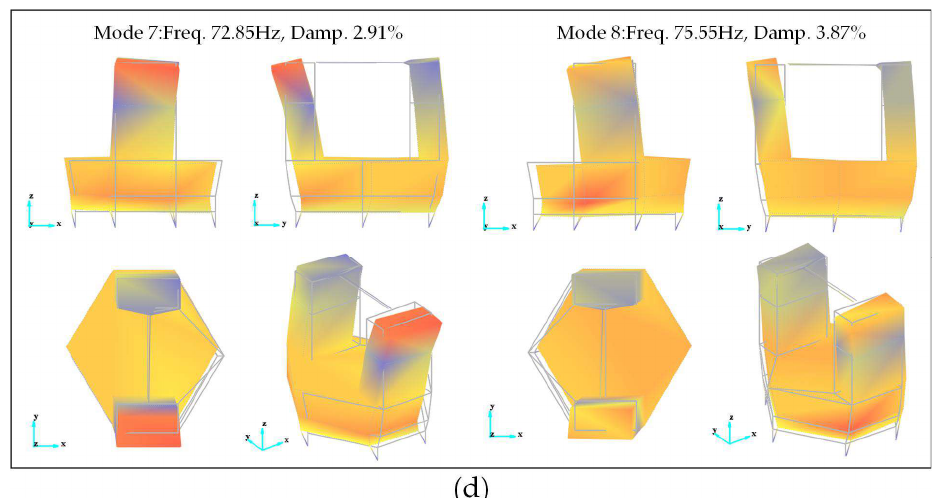
Figure 6. The first 8-order mode shapes of the modal test. ( a ) The first and second order mode shapes. ( b ) The third and fourth order mode shapes. ( c ) The fifth and sixth order mode shapes. ( d ) The seventh and eighth order mode shapes.